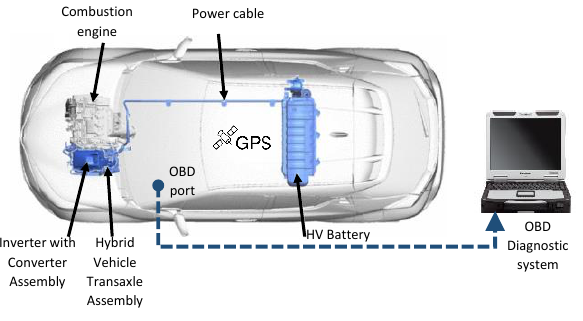
Fig. 1. A schematic of Toyota C-HR hybrid drive system along with the applied measuring devices (based on [18]) Toyota hybrid cars have four drive modes: Normal, EV, ECO and Power. After first starting the car, the system default settings is the ‘Normal’ drive mode, which automat- ically manages the most efficient use of both engines. Driv- er can also select one of the car’s on-demand drive modes to achieve better fuel consumption in certain circumstances.